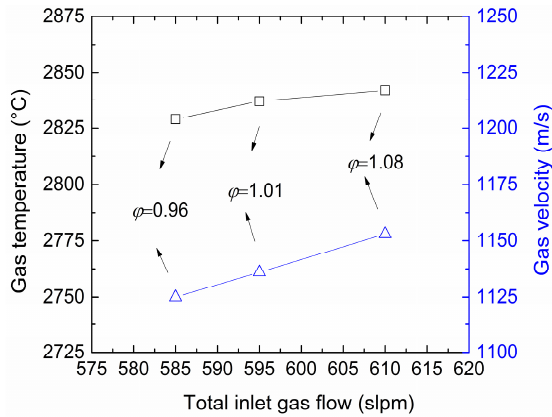
Figure 4. Calculated gas temperature and velocities in the throat of the nozzle at different total gas flow rates. The oxygen flow is constant at 395 slpm.